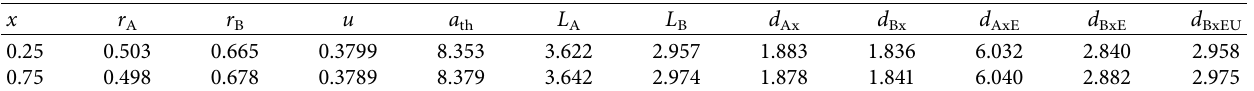
Table 3: Structural parameters of Ni � 0.25 and x � 0.75) annealed at 750 ° C, after Rietveld refinement (all in 1-x Zn x Fe 2 O 4 ferrite ( x